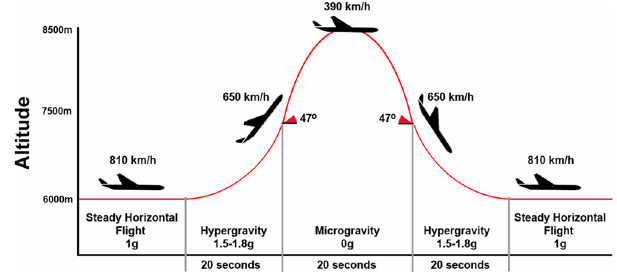
Figure 1. Flight trajectory during the parabolic